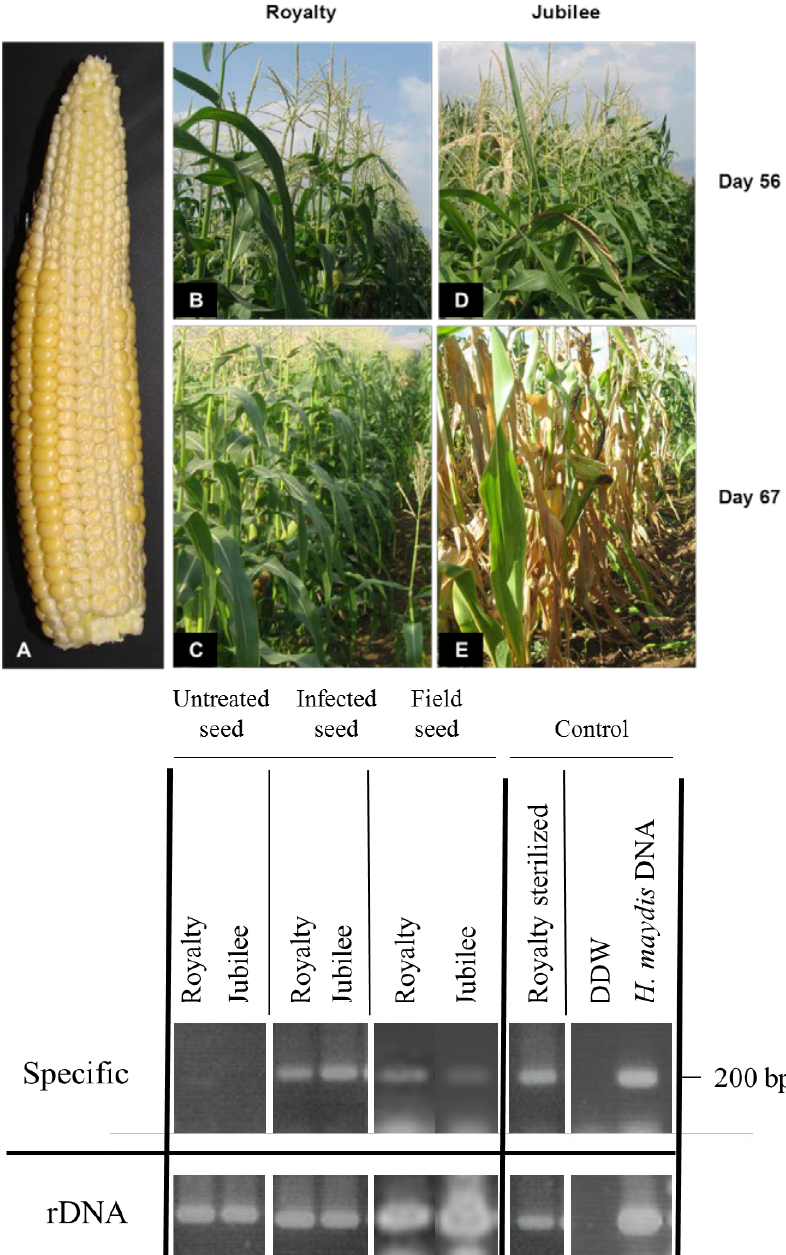
Figure 5. Molecular maize seed health assay for Harpophora maydis (cv. Royalty and Jubilee) in a Kibbutz Hulata, Israel maize field in summer of 2009 (upper panel): A , infected cv. Jubilee cob with shrunken and undeveloped seeds (defined as Class B cob), harvested 74 d after sowing; B, C , cv. Royalty plants, 56 and 67 d after sowing; D, E , cv. Jubilee at the same dates, showing late wilt symptoms. In the lower panel, untreated seed (healthy untreated seeds used as a negative control), infested seed (healthy seeds deliberately infested with H. maydis ), field seed (randomly selected seeds from naturally in - fected maize plants presented in the upper panel, 74 d after sowing), cv. Royalty sterilized (autoclaved ‘Royalty’ seeds used as a positive control to demonstrate the ability to detect fungal DNA under the experimental conditions), DDW (double distilled water), H. maydis DNA, specific (amplification to identify the H. maydis -specific oligonucleotide), and rDNA (18S eukaryotic ribosomal DNA